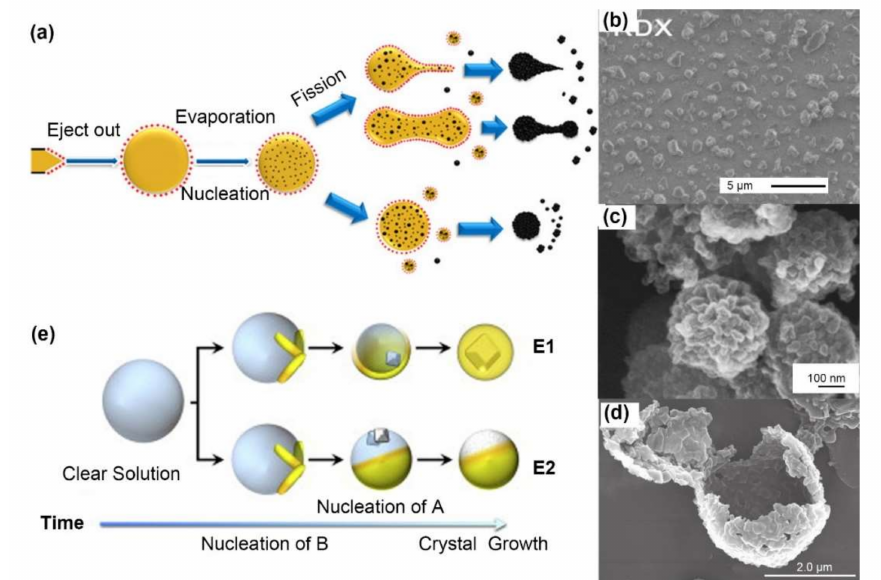
Figure 2. ( a ) Schematic of electrospray formation mechanism of sub-microspheres.